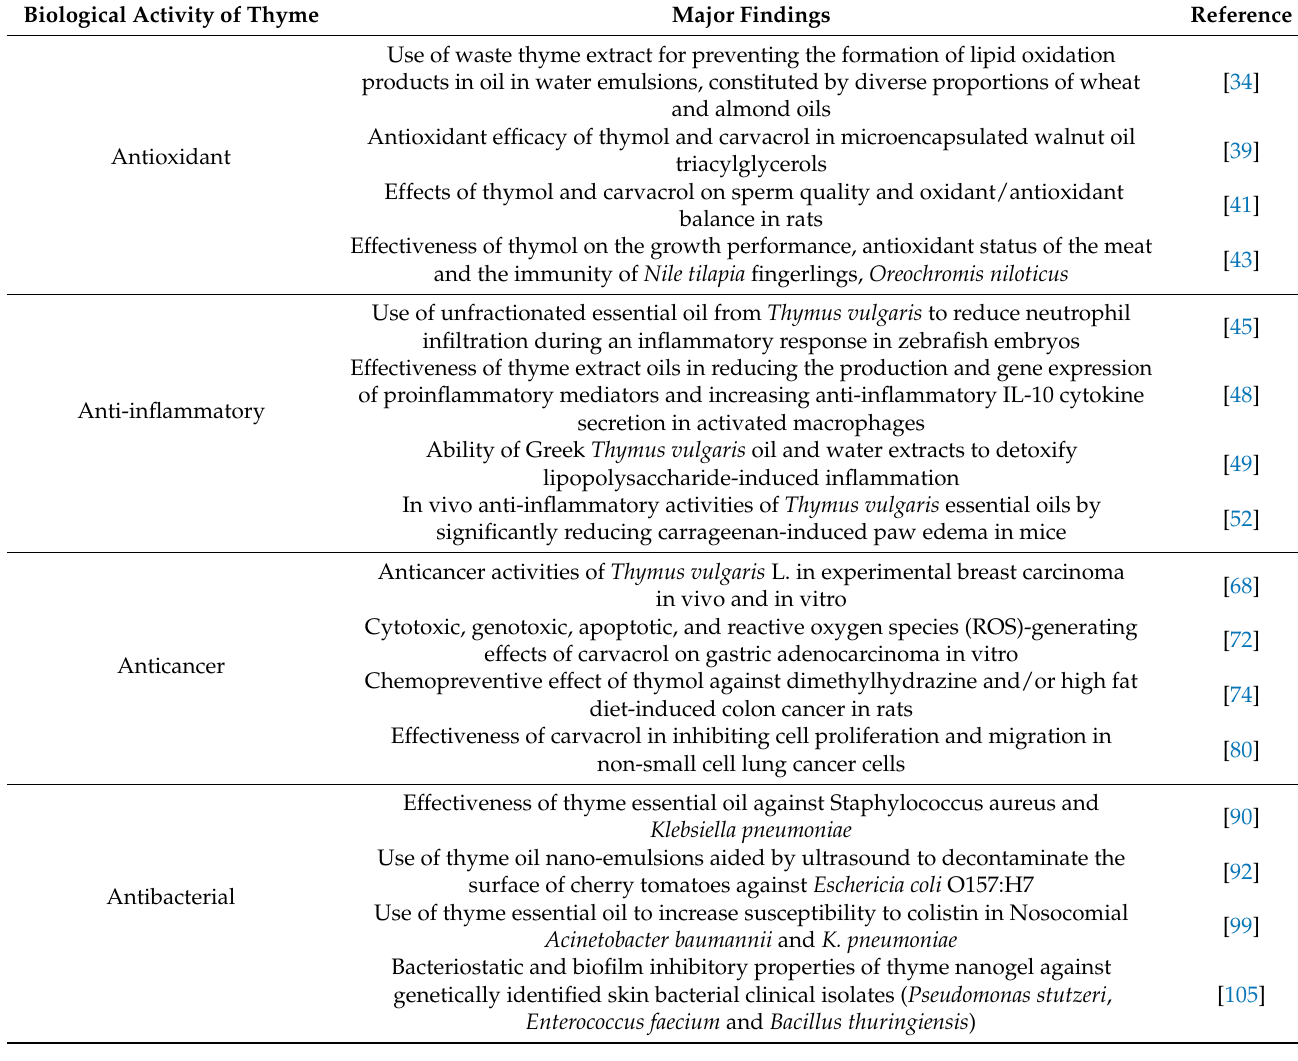
Table 3. Examples of some cited studies on the biological activities of thyme with main results and